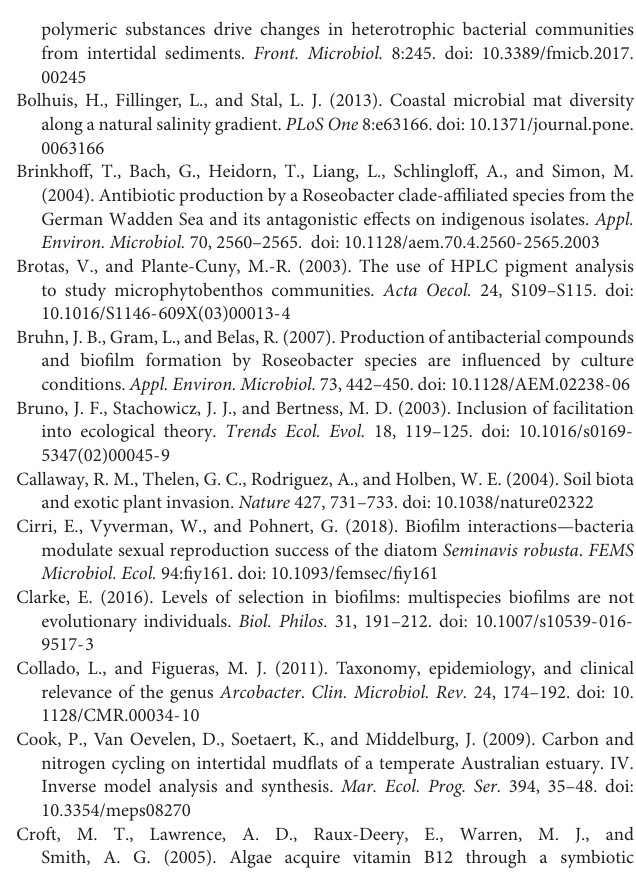
combinations of C. closterium (red), N. phyllepta (blue), and S. robusta (yellow). Samples with more diatoms present have circles with the appropriate colors combined. Gray arrows indicate the vectors of the bacterial OTUs with a cumulative loading larger than 30% on the first two axes. The bacterial genus or family is indicated depending on the closest hit. The proportion of the variance explained by each axis is indicated next to that axis. FIGURE S7 | Diversity levels of bacteria in the presence of different diatom combinations of C. closterium (C, red), N. phyllepta (N, blue), and S. robusta (S, yellow). Bacterial community diversity was calculated as the average number of predicted OTUs after rarefication of the samples to 781 reads. TABLE S1 | Information on the three different diatom strains used within our experimental setup. More information can be found at the Belgian Co-ordinated Collections of Micro-organisms website using the diatom accession number (http://bccm.belspo.be/catalogues). TABLE S2 | Composition of the mock community. The raw fastq data of the mock is available at NCBI Sequence Read Archive under the accession number SUB5539877. Briefly, the DNA was extracted and amplified for each strain individually and equimolar pooled afterward. The collection number refers to the identifier of the strains in the BCCM/LMG collection (bccm.belspo.be/about- us/bccm-lmg; LMG) or the research collection of the Laboratory of Microbiology Ugent (http://lmg.ugent.be; R). TABLE S3 | Statistical analysis of the total maximum growth rates derived from F 0 PAM values of 24-plate wells harboring different combinations of S. robusta [S], C. closterium [C], and N. phyllepta [N]. A two-way ANOVA was conducted testing the differences between the total growth rate of the diatom combinations (single, paired, or all together) and the presence or absence of bacteria. A post hoc (Tukey Test) was further conducted on each of the different diatom combinations. An asterisk marks results of significant value where ∗ < 0.05, ∗∗ < 0.01, and ∗∗∗ < 0.001.